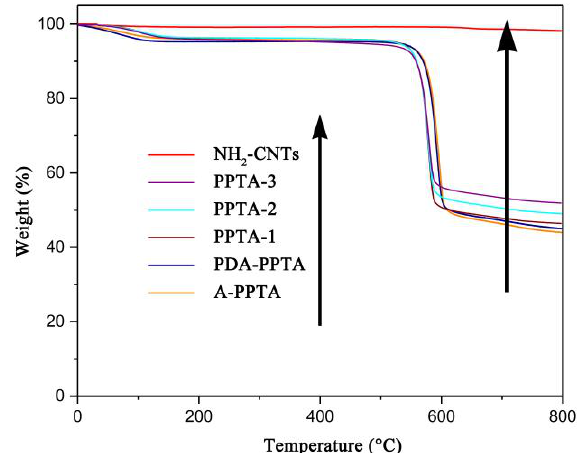
Figure 5. TGA curves of PPTA fibers and NH 2 -CNTs in the range of 30 °C to 800 °C.